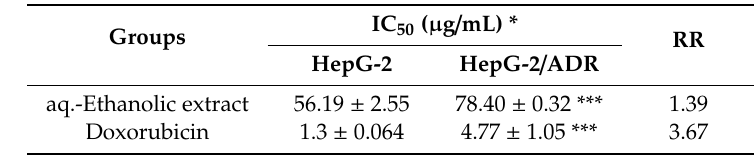
Table 5. The IC 50 values of Suaeda vermiculata aq.-ethanolic extract compared to DOX in HepG-2 wild types, and HepG-2 / ADR resistant cell-lines, and their relative resistance (RR) using MTT